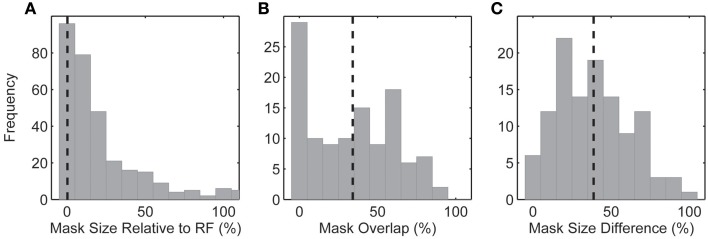
(A) Size of the spike-triggered mask relative to the spatial RF. (B) Fractional (%) overlap between the multiple spike-triggered masks derived from each neuron. Spike-triggered masks were calculated for each of the 2–6 underlying natural images. (C) Mask size difference between the multiple spike-triggered masks derived from each neuron. Percentage calculated relative to the largest spike-triggered mask for each neuron. Dashed lines indicate the mean of each distribution.